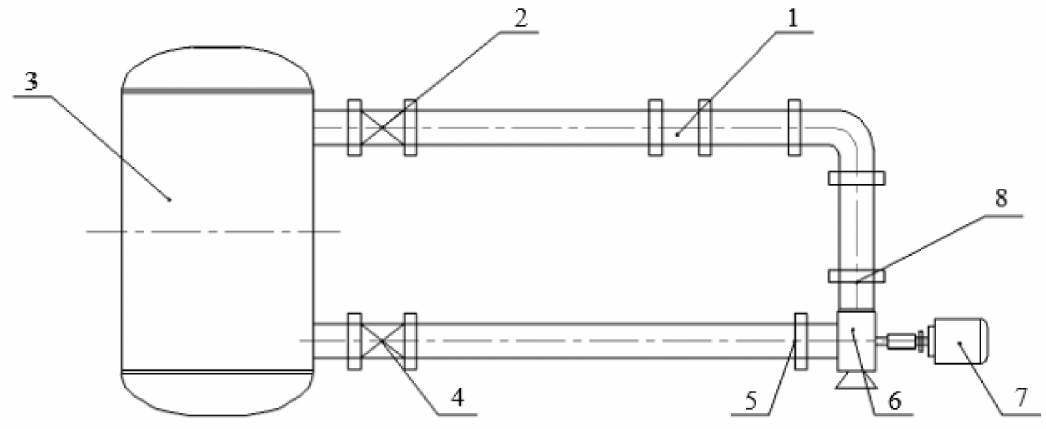
Figure 4. Schematic diagram of test facility.